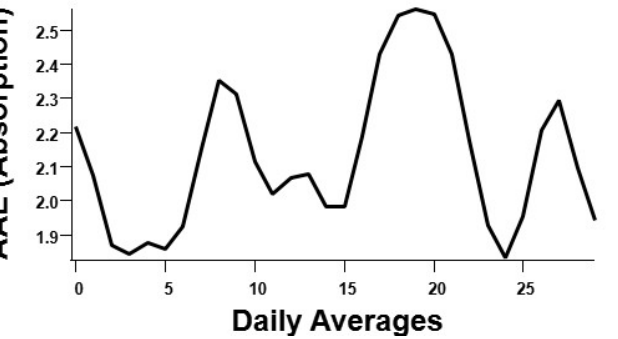
Figure 5. The absorption Ångstrom Exponent—Equation (1)—was calculated using the Babs calcu- lated at 405 nm and 870 nm with the data obtained by the PAX instruments. The values represent daily averages for the month of January 2022. A binomial smoothing was applied (IGOR Pro 8) to show the shape of the data.